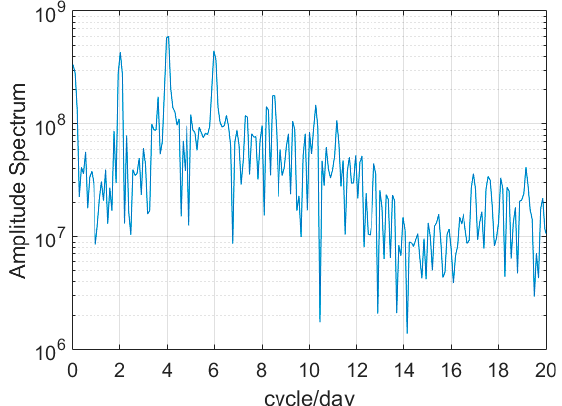
Figure 7. Spectrum analysis for 2-h slipping prediction residuals of G25 after eliminating the clock reference. Table 5. The root mean square (RMS) of 1-h, 2-h, and 3-h prediction using the improved model and 3-h observation.